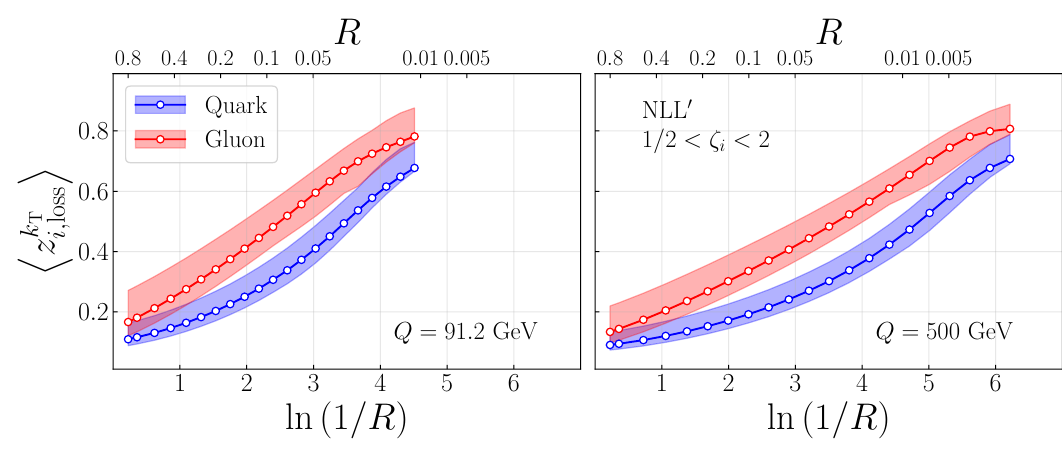
Figure 9 . Average energy loss of e + e − hemisphere leading jets h z k T separately show the quark and gluon results for an initial energy of Q = 91 . 2 GeV and 500 GeV as a function of the jet